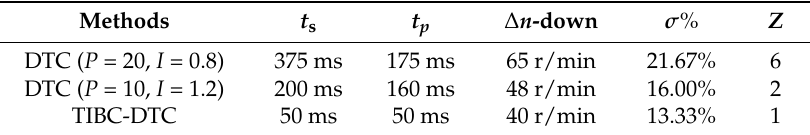
Figure 25. Experimental results of n r under DTC and TIBC-DTC. Table 5. Performance metrics of DTC and TIBC-DTC (Experimental results).